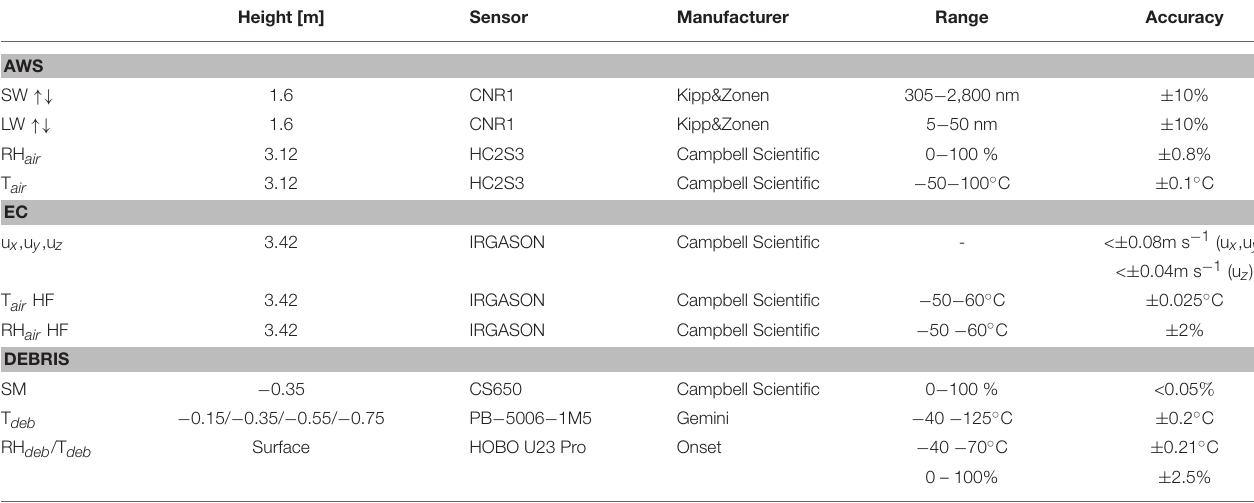
TABLE 1 | Sensor specifications for relevant measurements at the AWS and eddy correlation system (EC) and in the debris. Height [m] Sensor Manufacturer Range